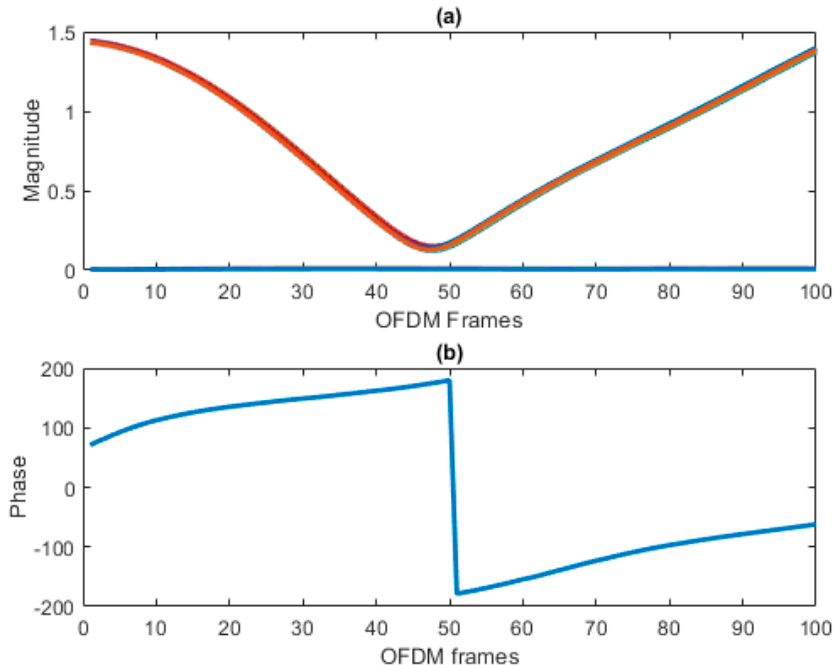
Figure 7. Fading channel response ( a ) magnitude; ( b ) phase.